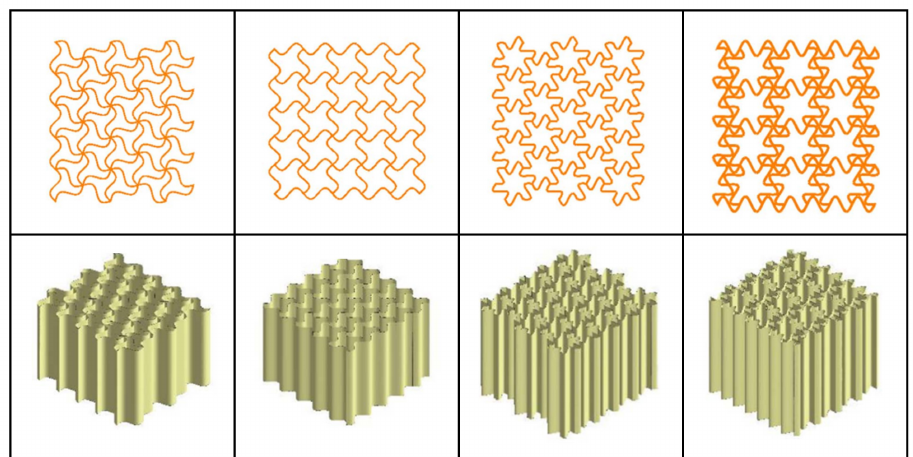
Figure 2. Horse-shaped honeycombs with different cross sections. Adapted with permission from Ref. [7]. Copyright 2018,